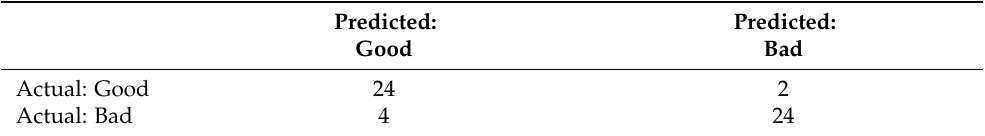
Table 4. Confusion matrix on the validation dataset ( n = 54) for the best accuracy model from Table 3.